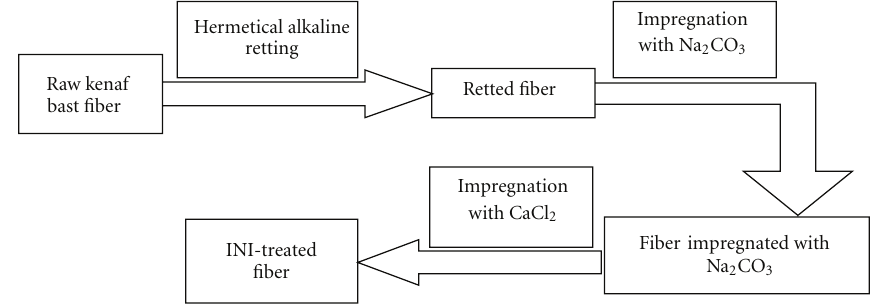
Figure 1: Flowchart of INI treatment.